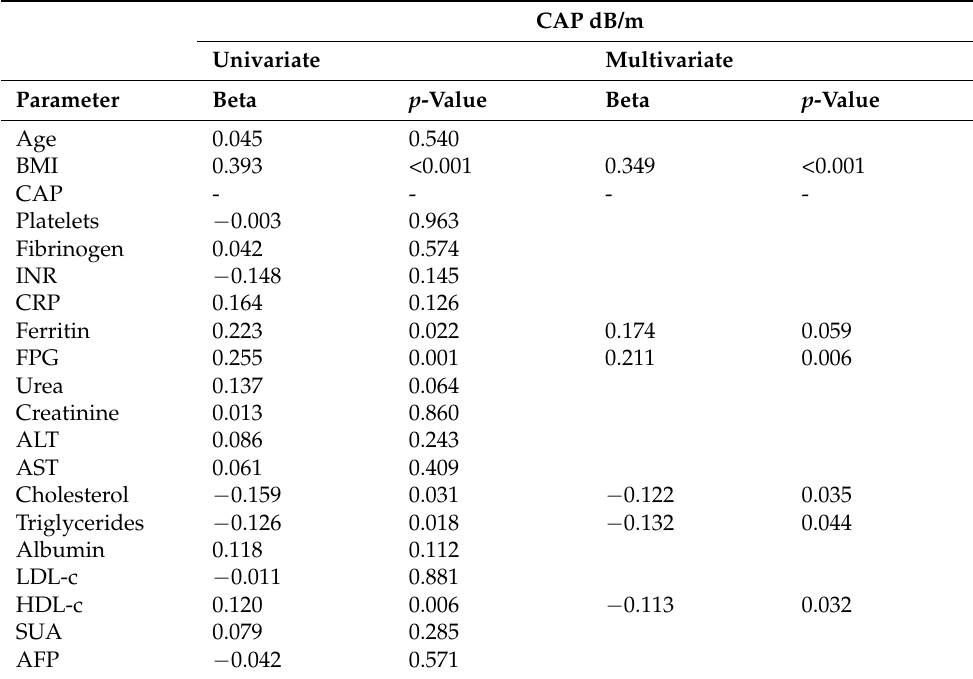
Table 4. Univariate and multivariate linear regression analysis of factors associated with an increased CAP score.